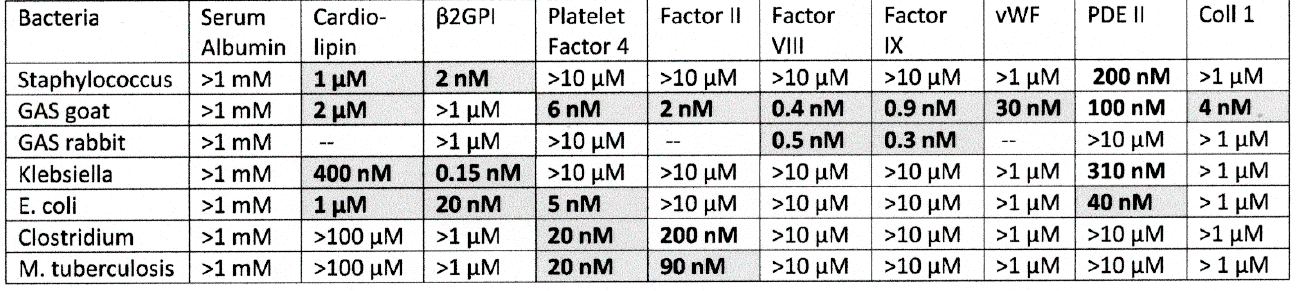
Figure 6. Summary of results of ELISA experiments exploring binding to blood proteins by bacterial polyclonal antibodies (rabbit or goat). Not all proteins were tested with rabbit-anti-GAS antibody: the missing tests are indicated by dashes. Binding constants were determined from the inflection point of the binding curves, some of which are illustrated in Figures 7–9. Significant binding is indicated by bolded numbers against a grey background. For the definition of significance, see Section 2.2. GAS = group A streptococci antibody; E. coli = Escherichia coli antibody; M. tuberculosis = Mycobacterium tuberculosis antibody; β2GPI = beta 2 glycoprotein I; vWF = von Willebrand Factor; PDE = phosphodiesterase II; Coll 1 = collagen 1.